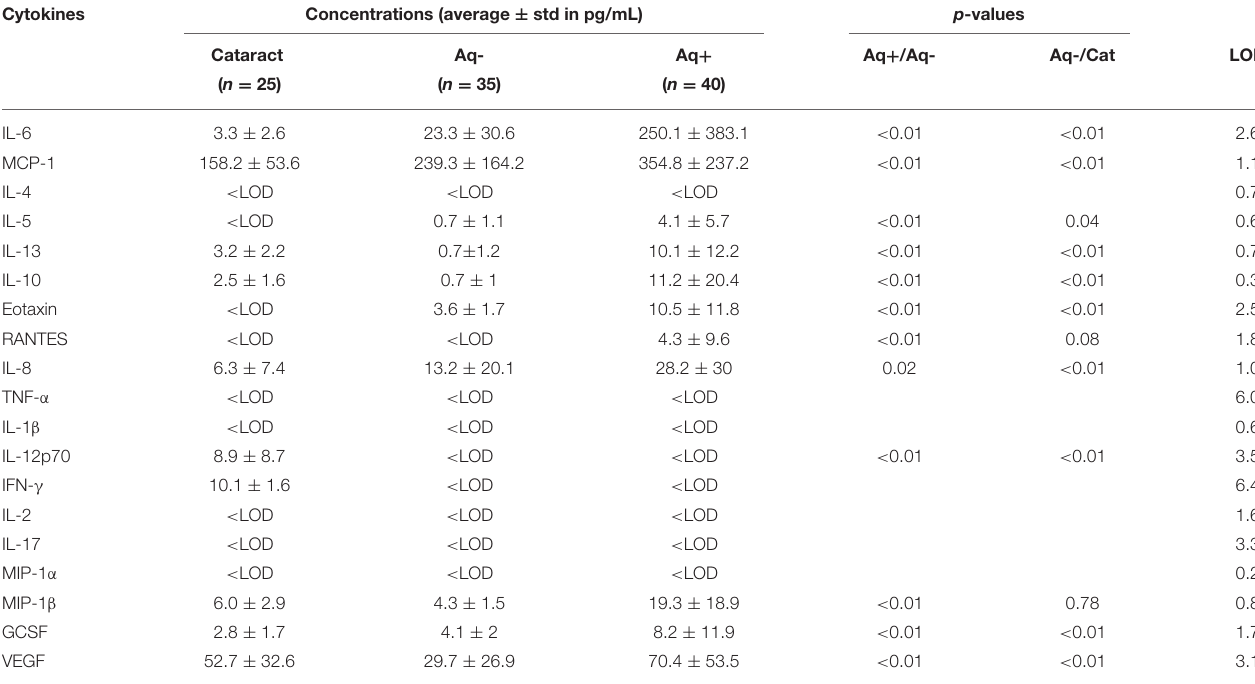
TABLE 5 | Aqueous cytokine concentrations.